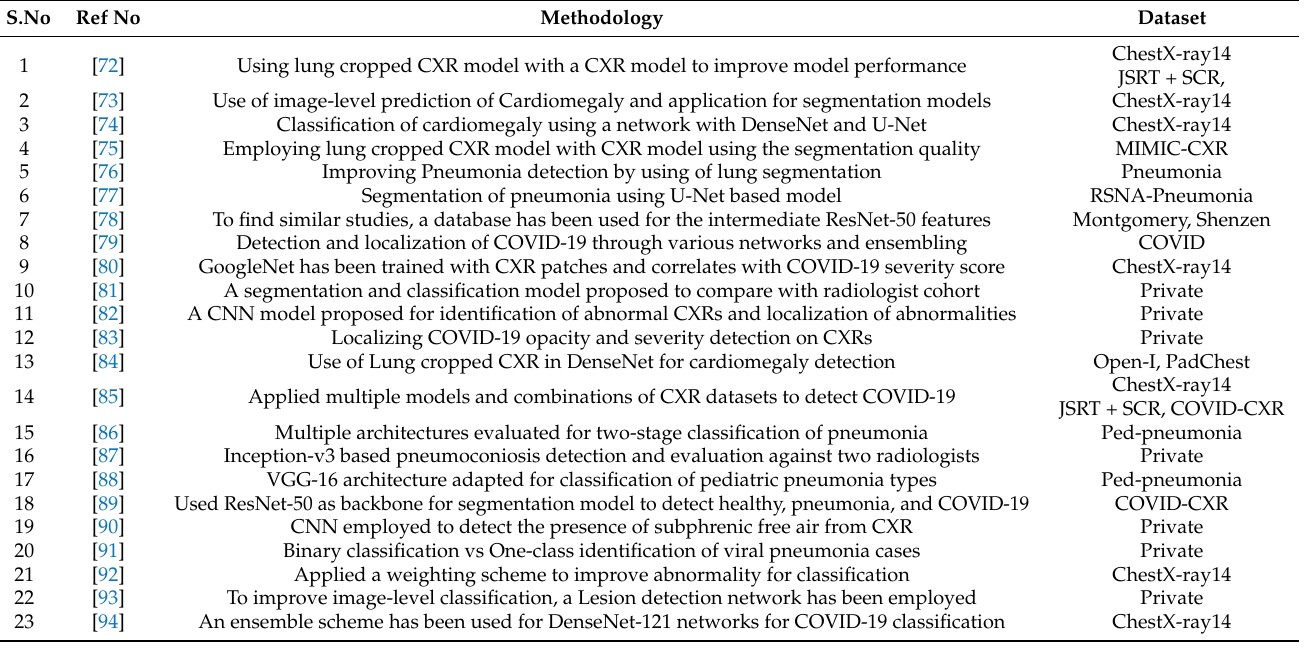
Table 3. List of popular Techniques for Classification and Localization using Weak Supervised